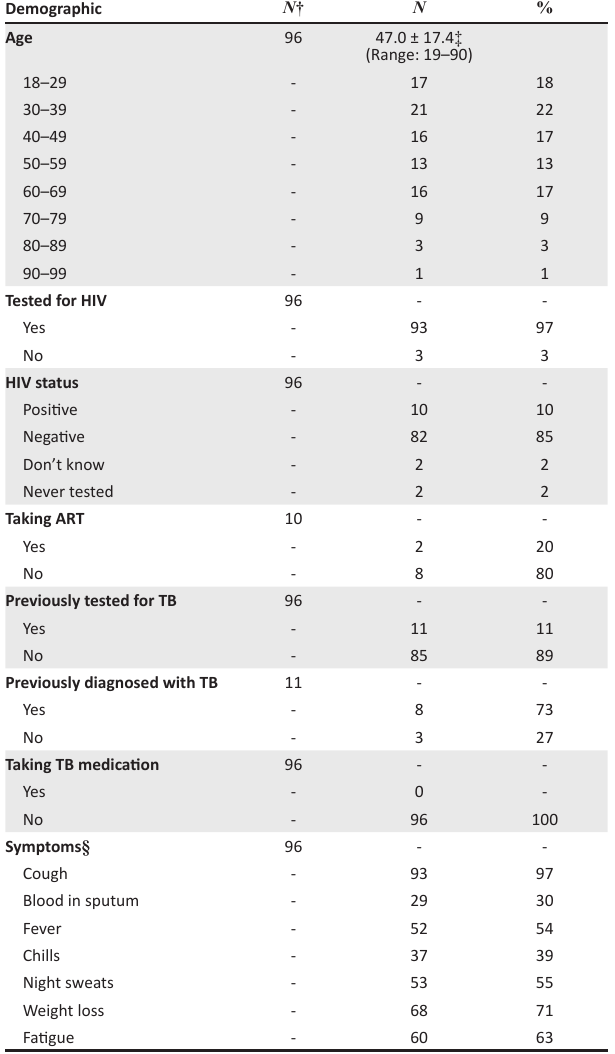
TABLE 2: Contingency table of acid-fast bacilli smear microscopy vs. tuberculosis